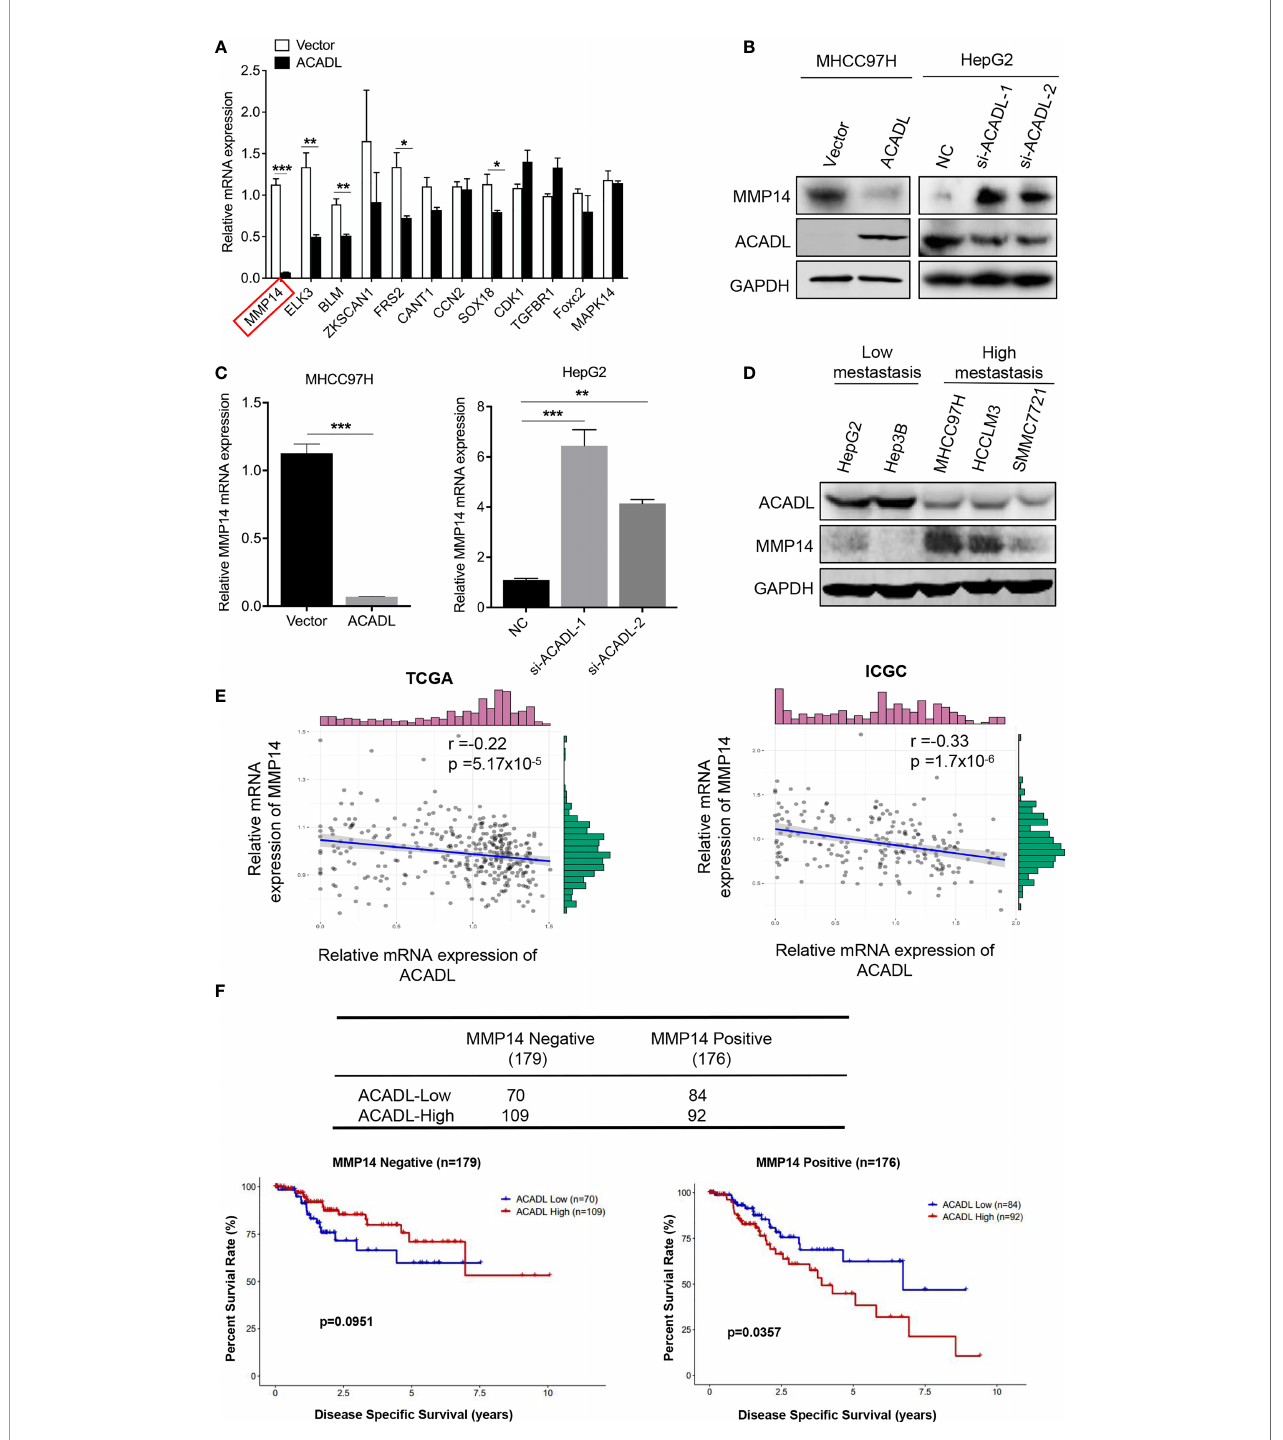
FIGURE 5 | MMP14 is negatively correlated with ACADL in HCC cells and patients. (A) ACADL regulates the expression of genes related to invasion and metastasis. (B) WB analysis was used to show ACADL and MMP14 expression in special MHCC97H and HepG2 cells. (C) MMP14 mRNA expression in special MHCC97H and HepG2 cells. (D) Protein expression of ACADL and MMP14 in HCC cell lines as determined by WB analysis. (E) Correlation analysis of ACADL and MMP14 in HCC specimens from TCGA and ICGC databases. (F) 355 HCC specimens were divided into different groups according to the expression levels of MMP14 and ACADL. The disease-speci fi c survival rates were compared between the ACADL-low expression and ACADL-high expression groups in the MMP14 positive group and MMP14 negative group. *P < 0.05, **P < 0.01 and ***P < 0.001 compared with